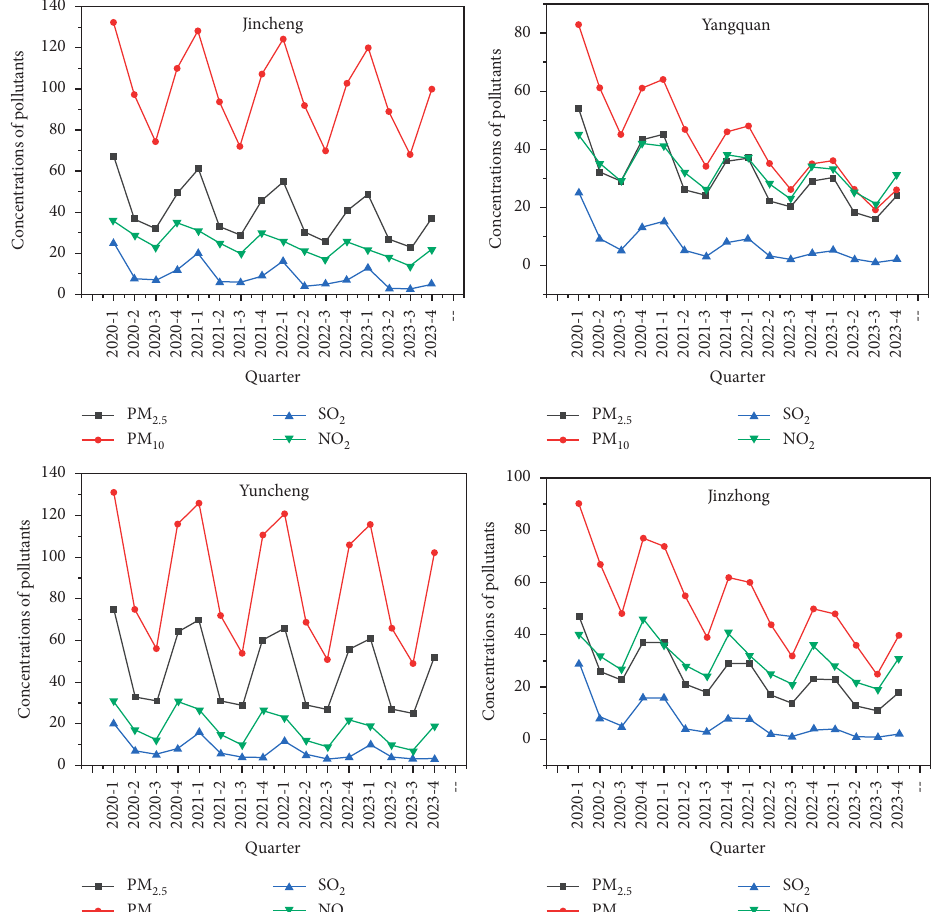
Figure 4: The predicted concentration of four pollutants in four cities in Shanxi